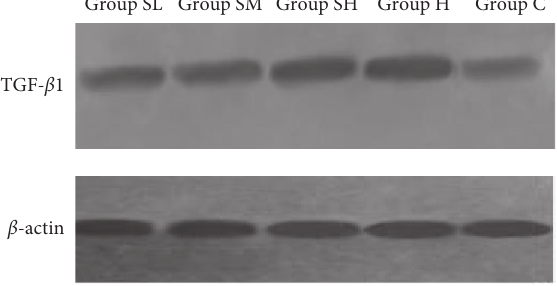
Figure 4: Expression of TGF- β 1 protein by western blot.